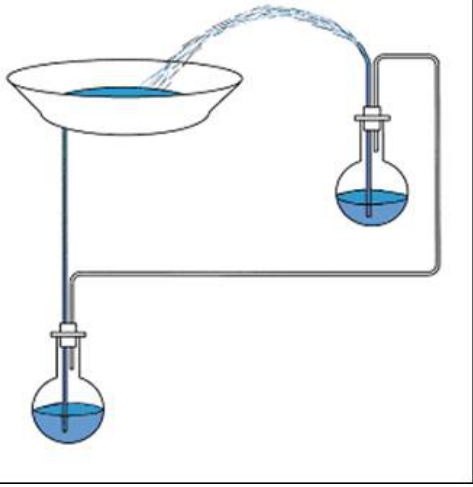
Figure 13. The magic fountain of Heron (Adapted from [49]).